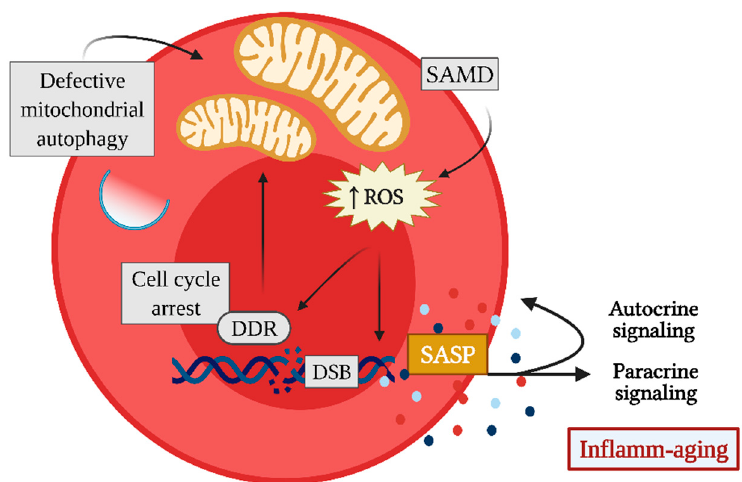
Figure 2. Hallmarks of cellular senescence. Senescence induction can be triggered by multiple stimuli that converge to irreparable DNA damage, such as double-strand breaks (DSB), which activate the DNA damage response (DDR) and lead to cell cycle arrest to prevent replication of the defective cell. Sustained DDR induces senescence-associated mitochondrial dysfunction (SAMD), which together with defective autophagy leads to the accumulation of dysfunctional mitochondria and, consequently, to the increased production of reactive oxygen species (ROS). ROS by themselves are capable, on the one hand, of maintaining DNA damage foci and, on the other hand, of constituting messengers in signal transduction of transcription factors of the senescence-associated secretory phenotype